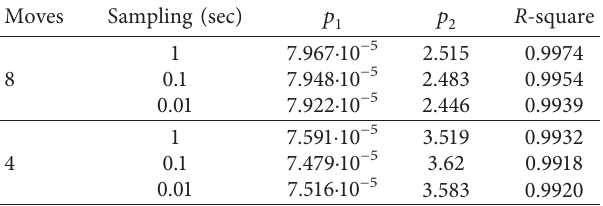
Table 2: Linear curve fitting for number of visits per visited cell. Moves Sampling